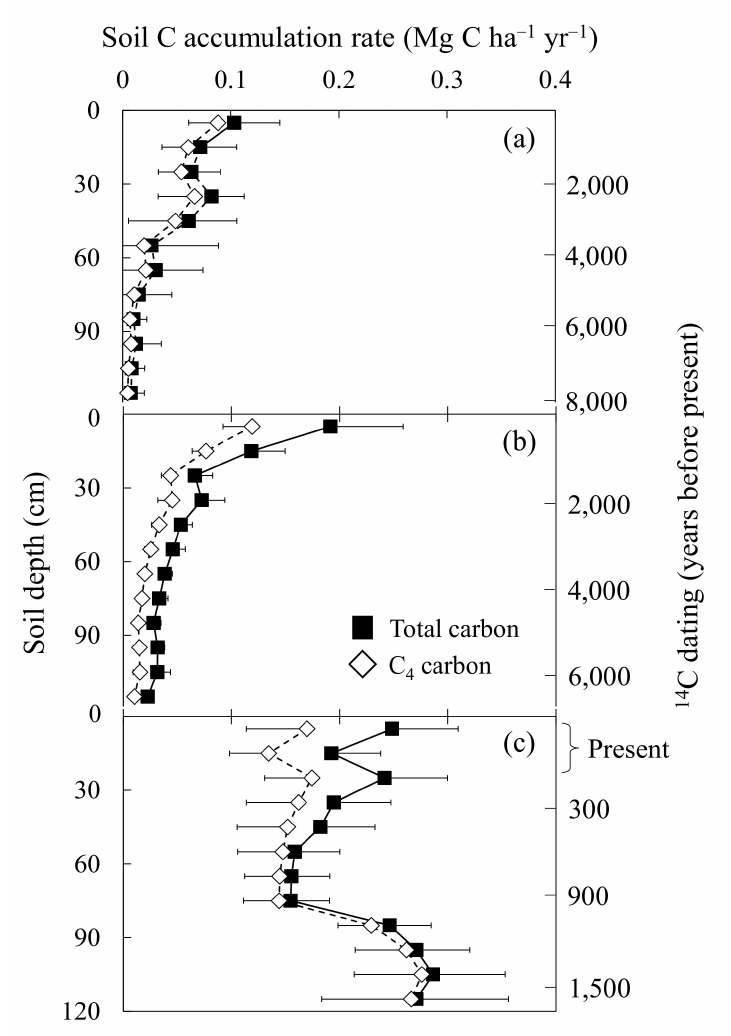
Figure 4. Soil carbon accumulation rate and relative soil age (years before present) for C 4 -derived C (clear diamonds) and total C (black squares) to a 1.2 m in three semi-natural Miscanthus sinensis grassland sites in Japan: Aso-Kuju National Park, Kyushu Prefecture (ASO) ( a ); Kawatabi Field Science Center, Miyagi Prefecture (KAW) ( b ); and Soni Plateau, Nara Prefecture (SONI) ( c ). Error bars represent the standard